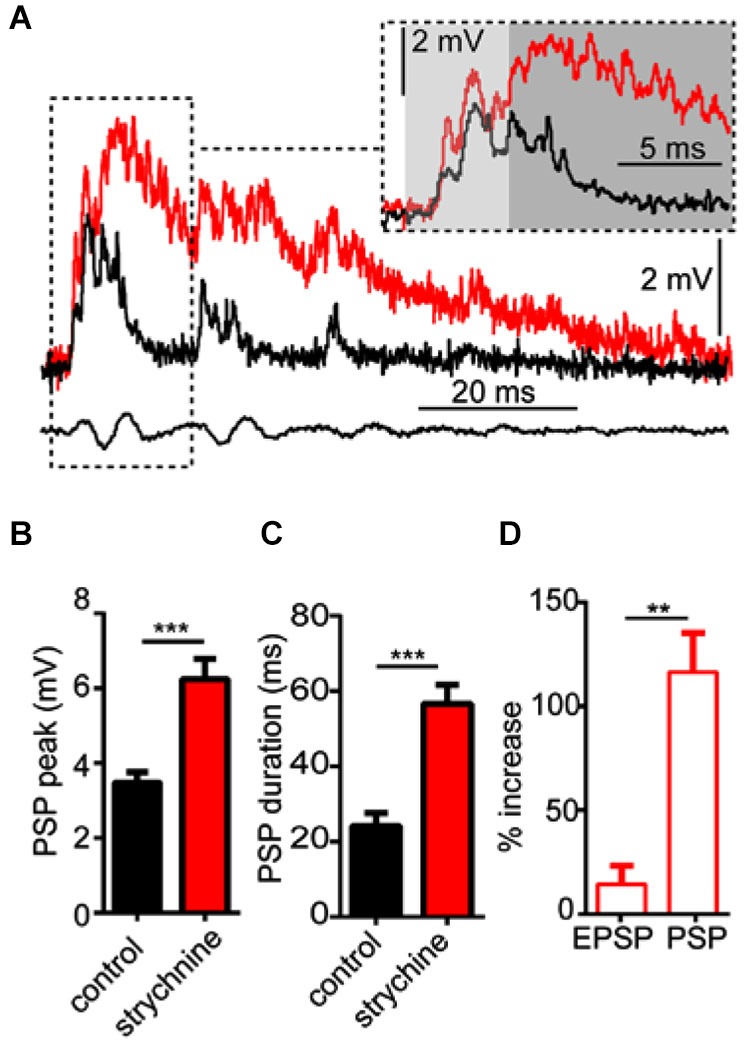
Glycinergic inhibition mediates auditory processing in the M-cell. (A) Sample intracellular recordings from the Mauthner-cell (M-cell) soma in response to an individual sound pip before (black trace) and after (red trace) treatment with strychnine. The insetshows the initial part of the evoked response at an expanded time scale. Light and dark shaded areas distinguish the initial (EPSP; 0–5 ms) and later components (mixed PSP; >5 ms) of the response, respectively. Bottom traces show sound stimulus (200 Hz single-cycle “pip” at 80 dB re: 20 μPa). (B) Plots of mean (± SEM, N = 9) overall peak amplitude of sound-evoked depolarization in control (black bar) and strychnine (red bar) conditions. (C) Plots of mean (± SEM, N = 9) PSP duration (Tau) before (black) and after (red) treatment with strychnine. (D) Plots of the mean (± SEM, N = 9) relative change in sound-evoked depolarization for the initial (EPSP) and later parts (mixed PSP) of the sound response after treatment with strychnine. Asterisks indicate p values in statistical comparisons that were < 0.01 (**), < 0.001 (***).